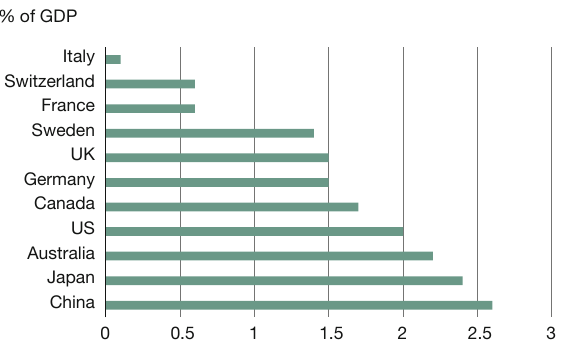
Fiscal stimulus in advanced countries % of GDP